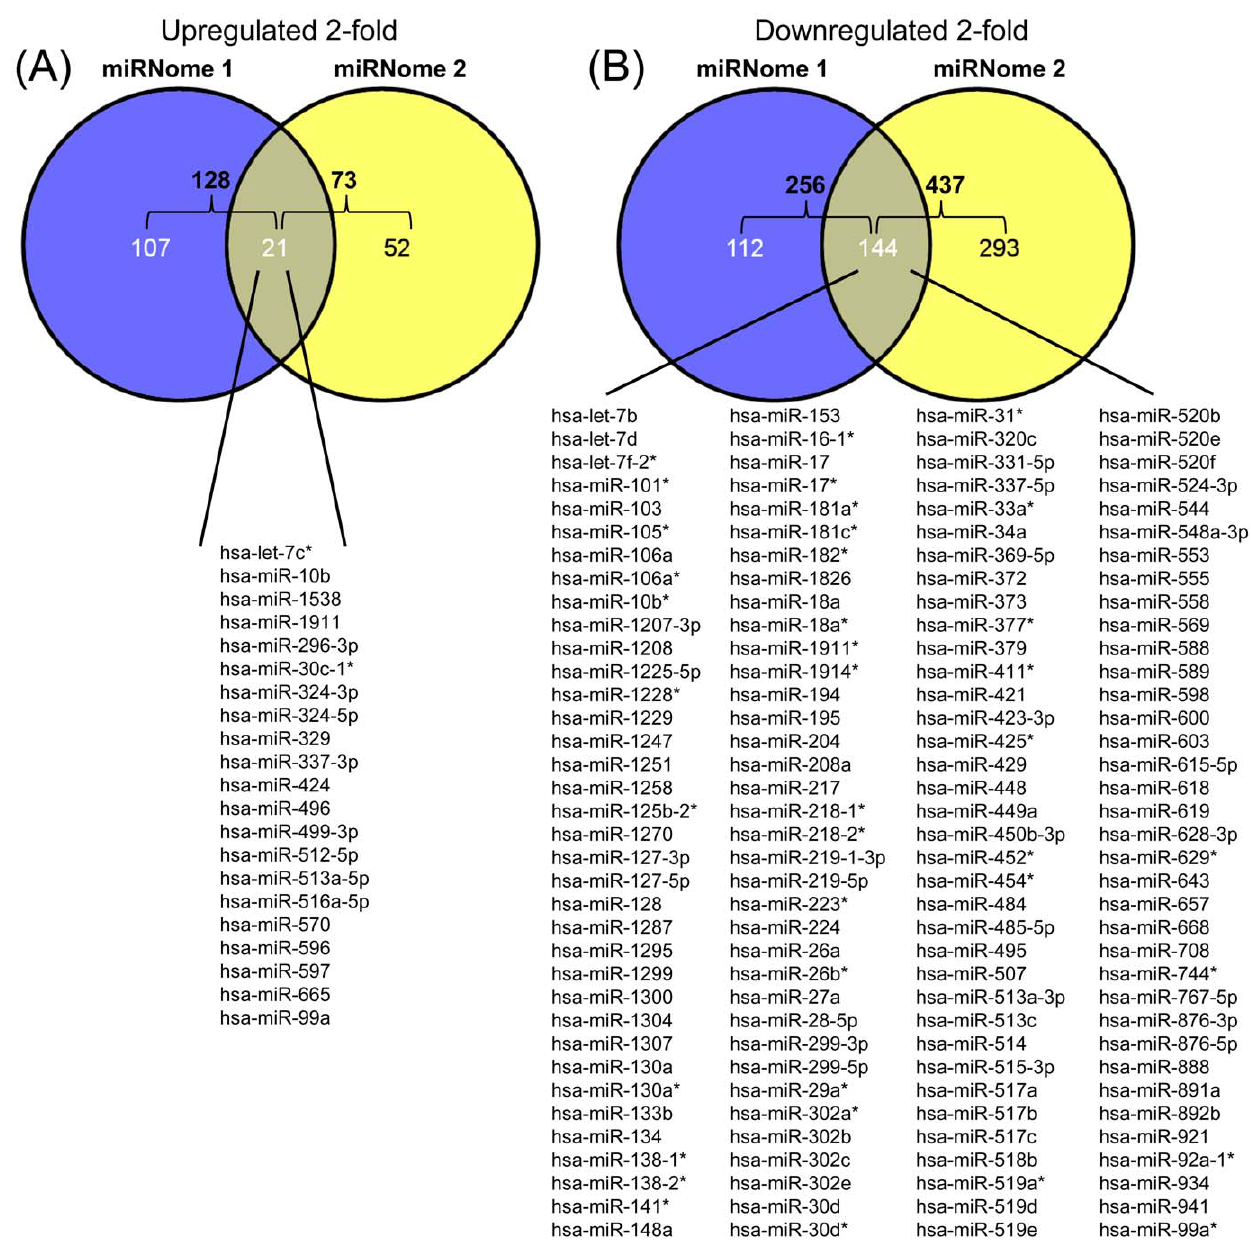
Figure 2. Upregulated and downregulated miRNAs in young and old individuals. A Venn diagram showing miRNAs that expression was either upregulated . 2-fold (A) or downregulated . 2-fold (B) in the old participants compared to young participants from the two different miRNome analyses in Figure 1. Listed are the miRNAs that overlapped between these 2 different data sets. The complete miRNome analysis for the listed miRNAs is available (Table S2).